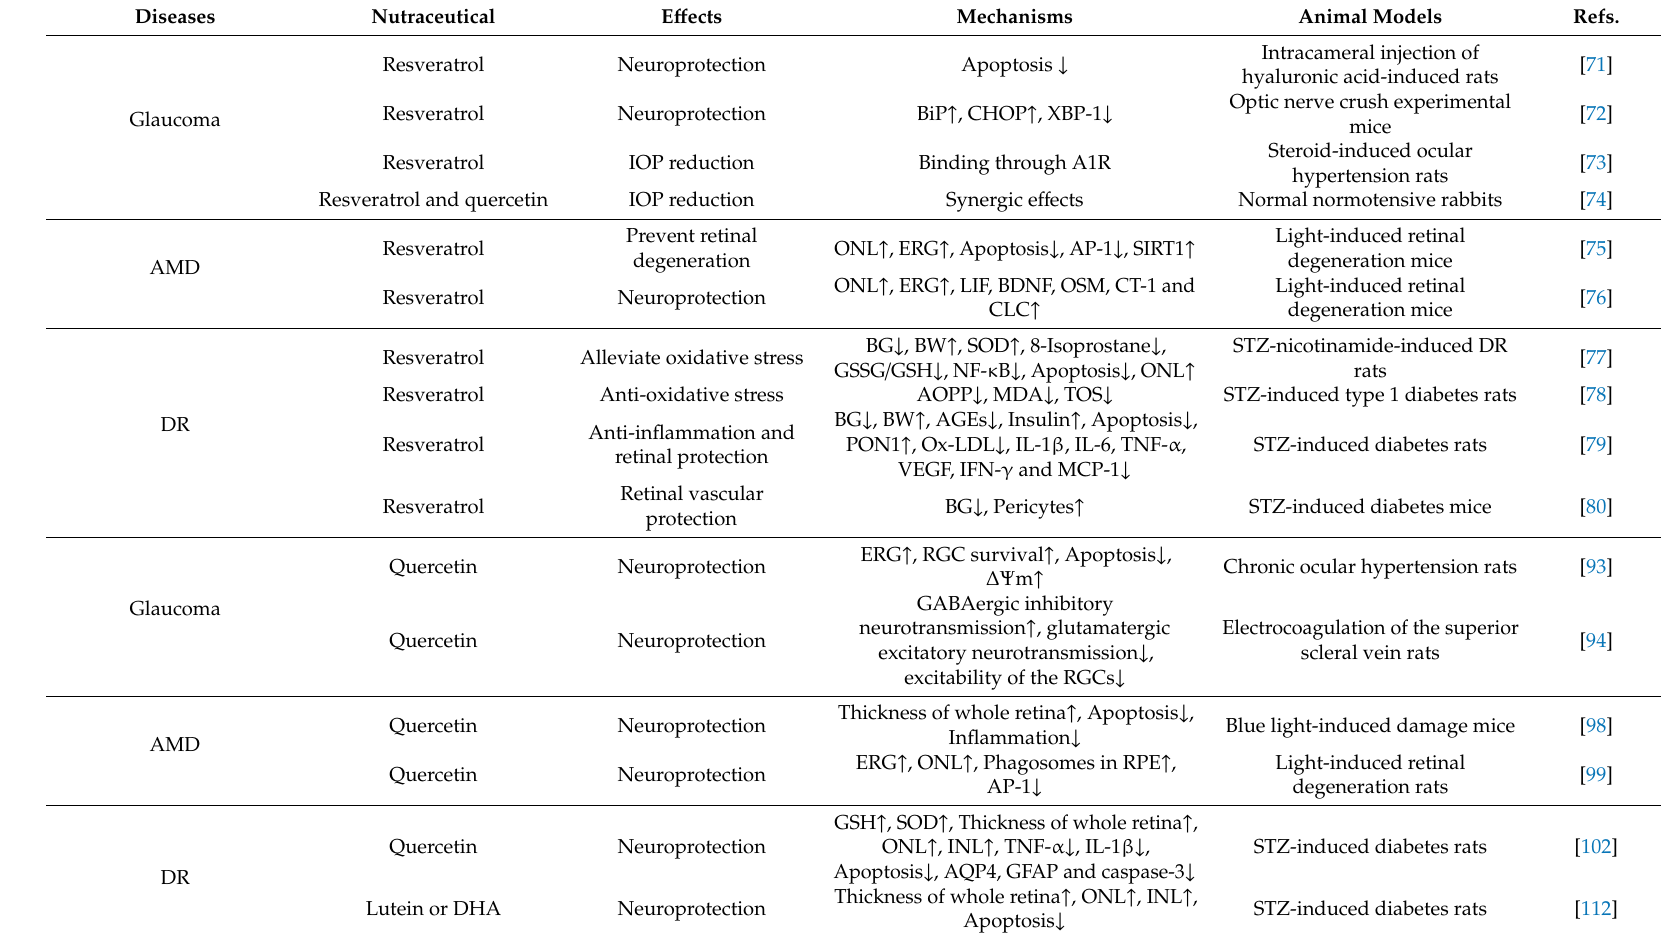
Table 1. Mechanisms of ocular neuroprotection by nutraceuticals in animal